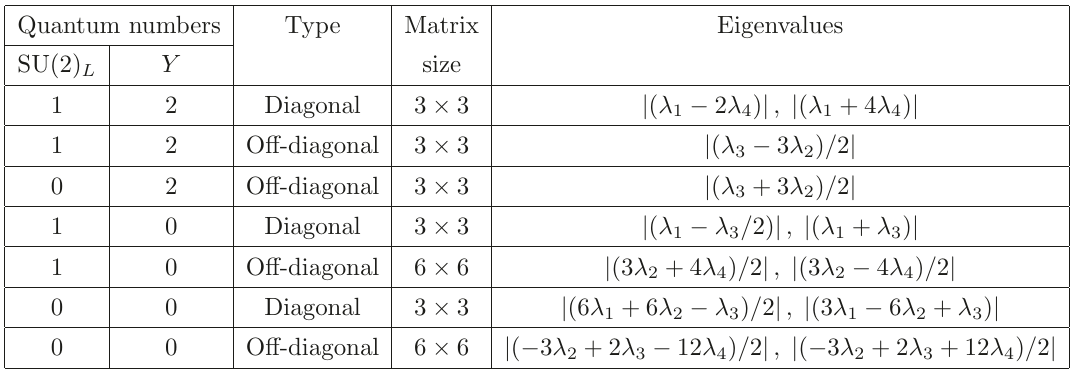
Table 1 . The dimensionalities and eigenvalues of the tree-level scattering matrices for the different SU(2) L and Y sectors. ‘Diagonal’ (‘Off-diagonal’) corresponds to i = j ( i From unitarity the magnitude of each eigenvalue must be bounded by 1/8 π